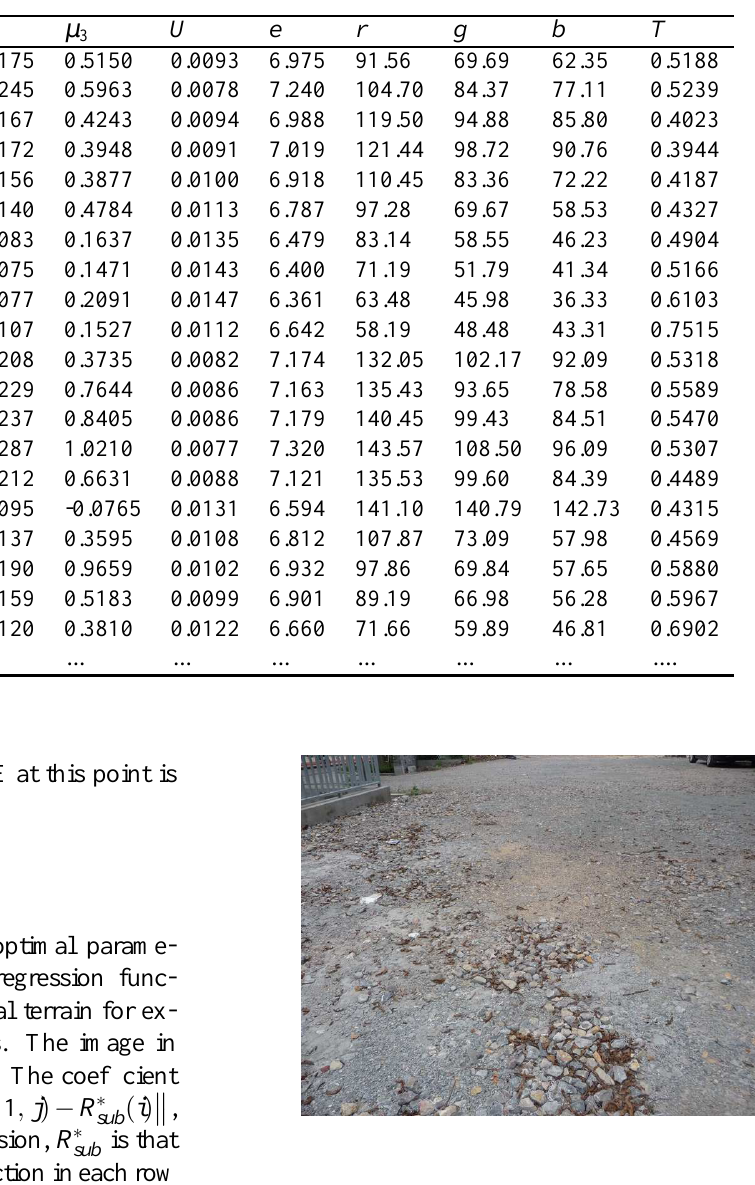
Fig. 8. The image of the terrain in the experiment